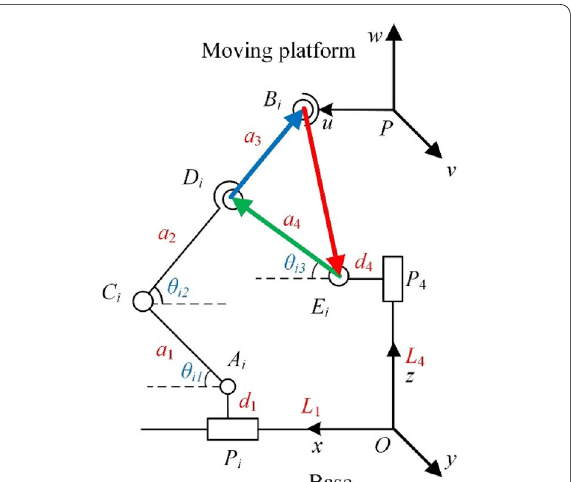
Figure 5 Diagram of closed-loop 2